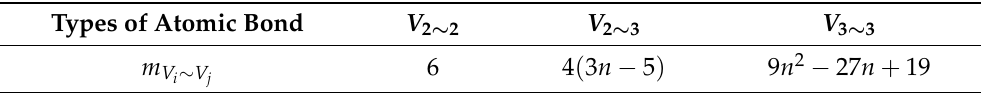
Table 3. Atomic bond partition of CNB n